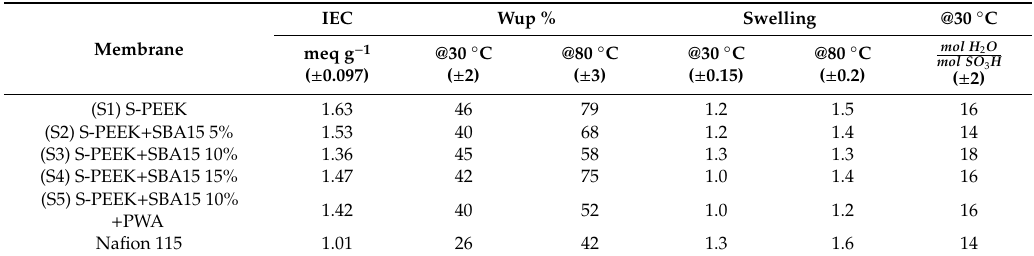
Table 2. Values of water uptake, swelling, ion exchange capacity and ohmic resistance at 30 ◦ C for several composite